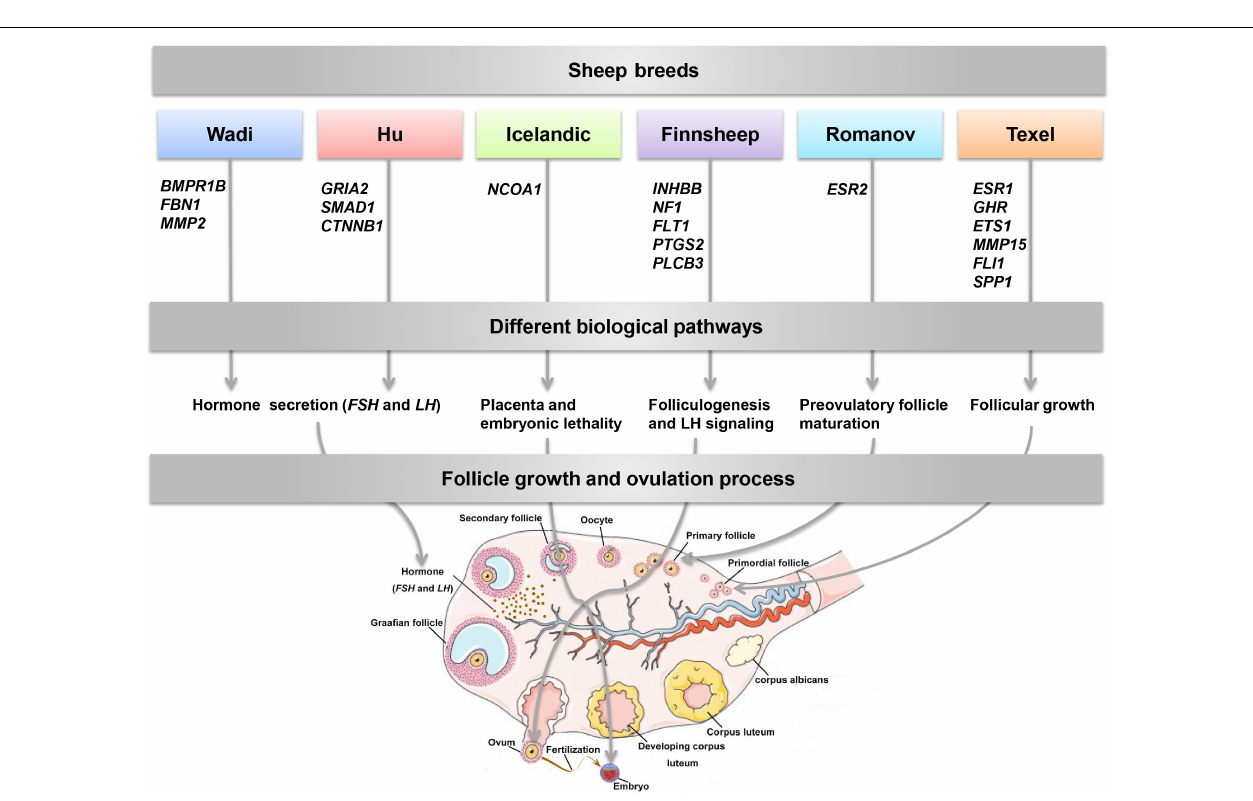
FIGURE 8 | Heatmap of the candidate genes identified from six sheep breeds (WAD, Wadi sheep; HUS, Hu sheep; ICE, Icelandic sheep, FIN, Finnsheep, ROM, Romanov sheep, and TEX, Texel sheep) enriched for expression in different ewes tissues deposited in the EBI Gene Expression Atlas database. The FPKM (fragments per kilobase of transcript per million mapped reads) value is used to measure the expression level.